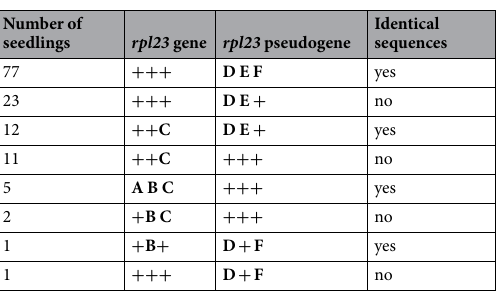
Number of seedlings